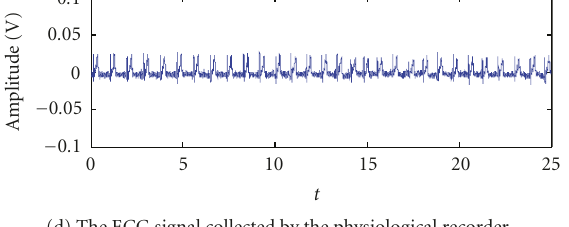
Figure 6: The extraction of heartbeat signal by wavelet analysis.